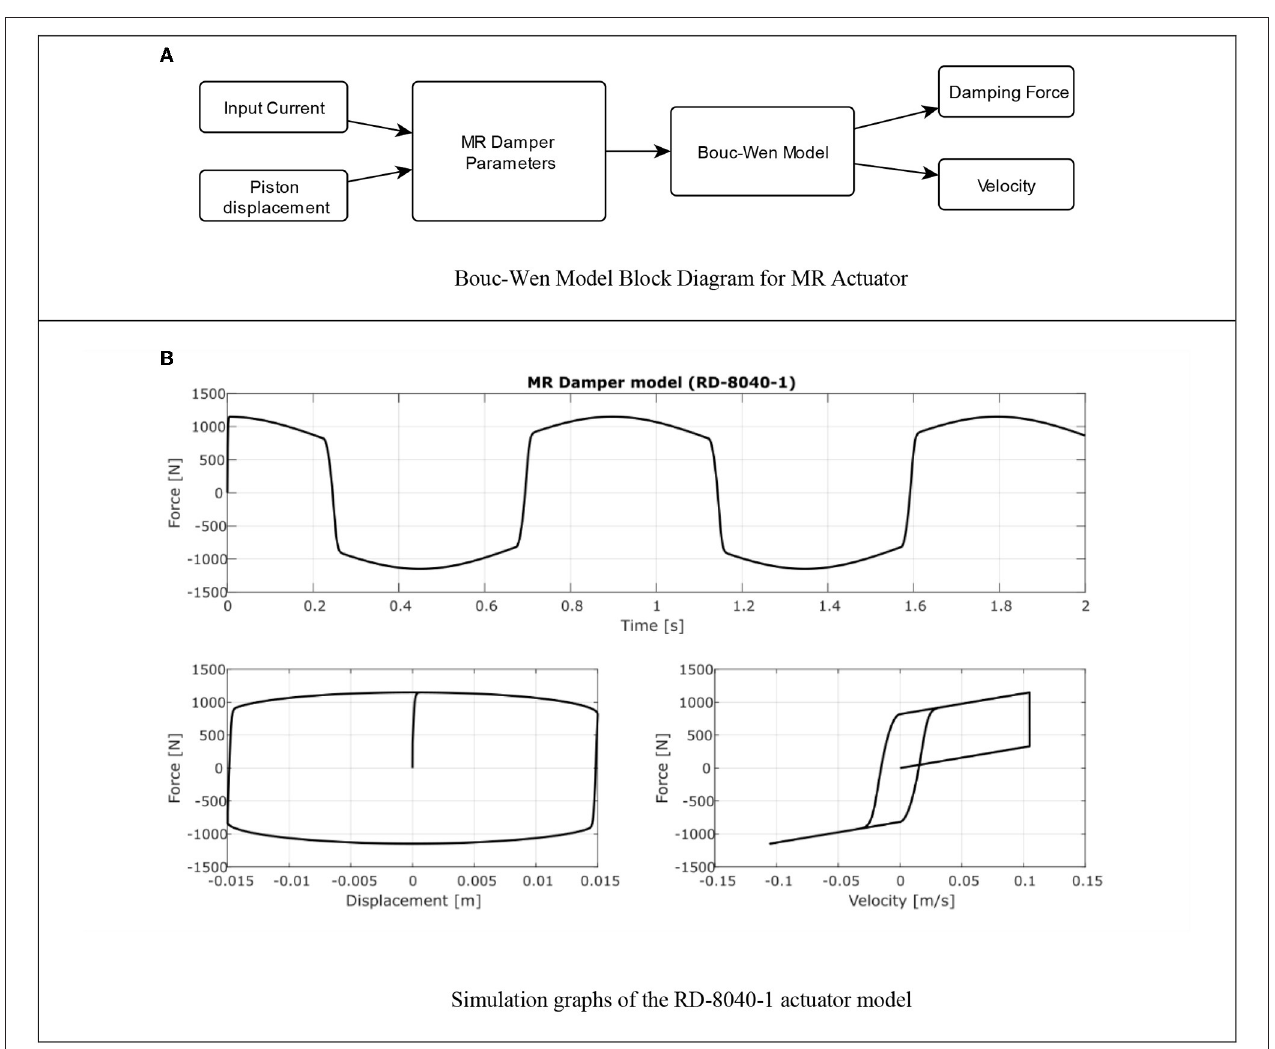
FIGURE 9 | MR Damper simulation. (A) Bouc-Wen model block diagram for MR actuator. (B) Simulation graphs of the RD-8040-1 actuator